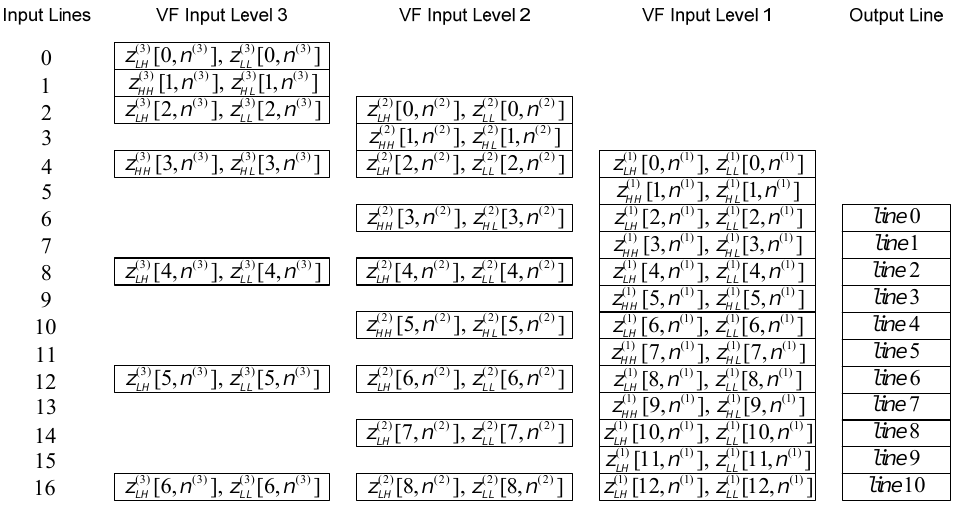
Figure 15. The time diagram of the beginning of the line ‐ wise filtering.